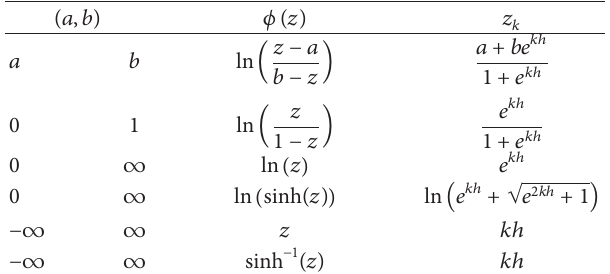
Table 1: Conformal mappings and nodes for several subintervals of 𝑅